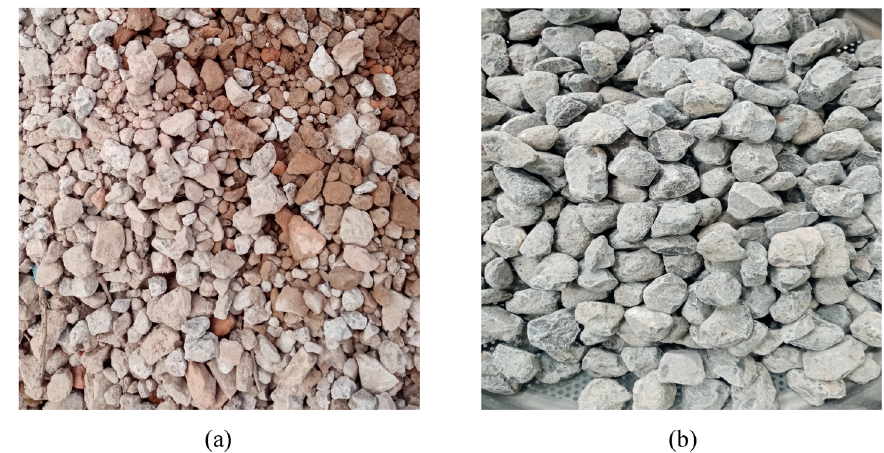
Figure 3: Comparison before and after removing mortar: ( a ) original RCA and ( b ) treated